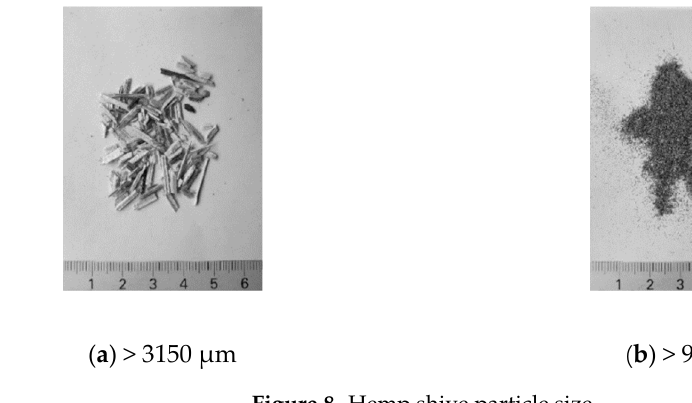
Figure 8. Hemp shive particle size.